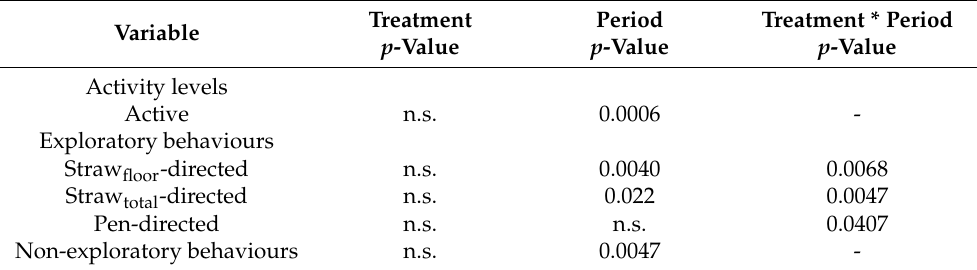
Table 3. Final models used for evaluation of treatment effect (RACK vs. CONTROL) on activity levels and exploratory behaviours. The interaction between treatment and period (Treatment * Period) was removed from the model if proven non-significant based on AIC values.